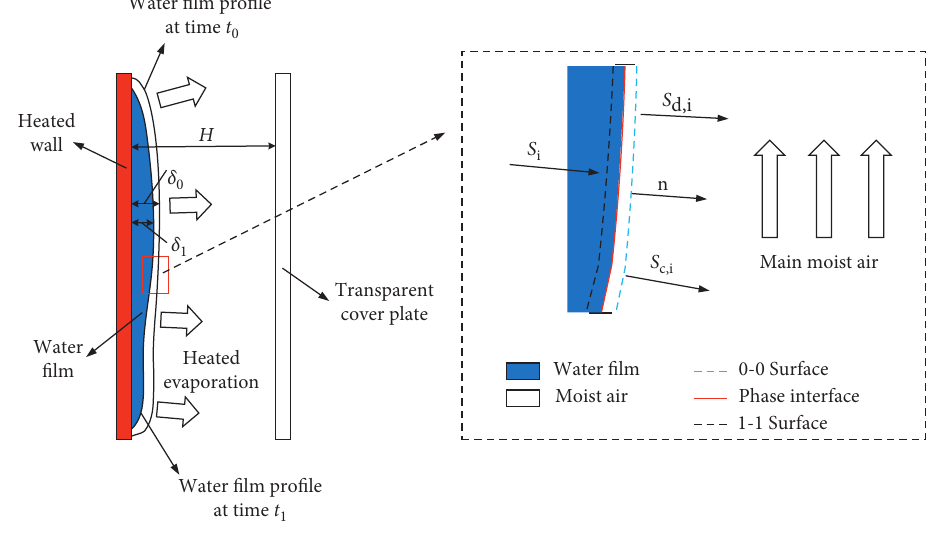
Figure 2: Schematic diagram of mass transfer for water film evaporation on the heated